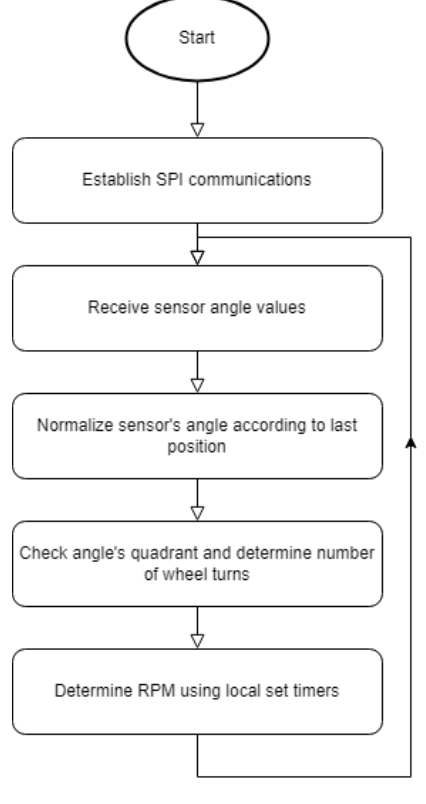
Figure 5. Magnetic encoder speed acquisition